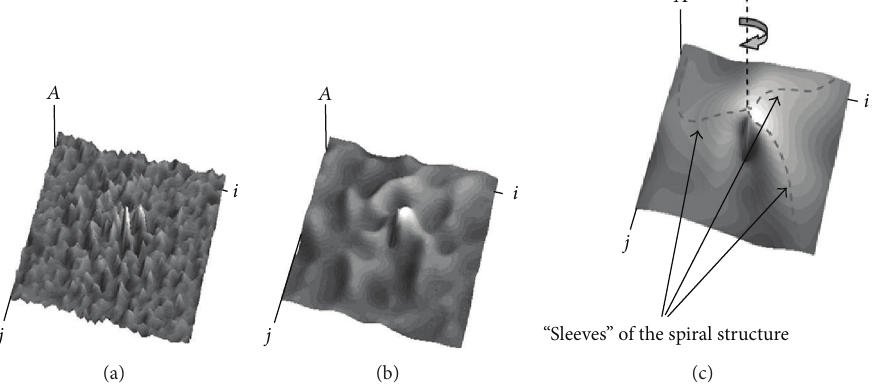
Figure 9: Surfaces of deformation work 𝐴 𝑖,𝑗 = 𝑆 𝑖,𝑗 ⋅ ℎ in an axial shear field corresponding to the first (a), 20th (b), and 150th (c) iterations for a single-layer model with the parameters listed in the